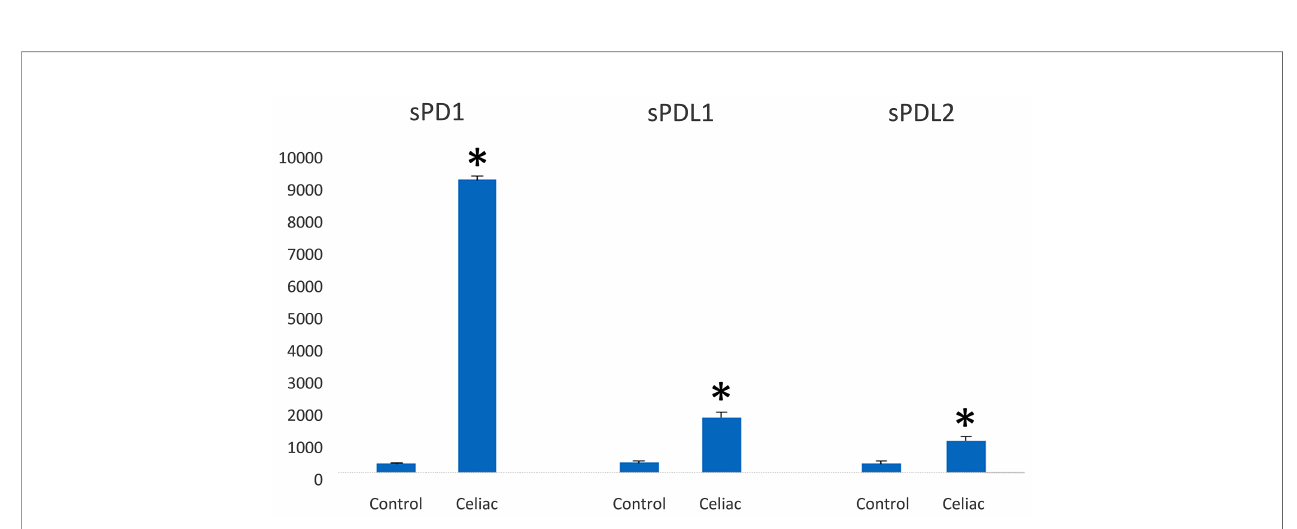
FIGURE 6 | PD-1/PD-L1 expression in the serum of celiac disease patients and healthy controls (pg/ml). PD-1 and PD-L1 are highly expressed in serum from celiac disease patients (n = 25) in relation to healthy controls (n = 5). Signi fi cant difference at * p <0.05 is